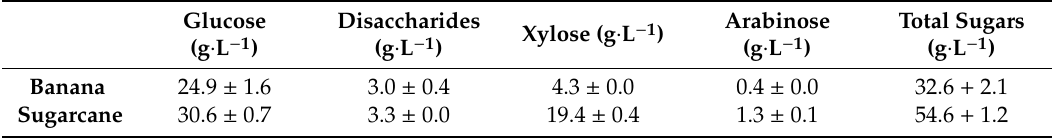
Table 2. Sugar types, content and total sugars (g · L − 1 ) of banana peduncles (15% DM) and